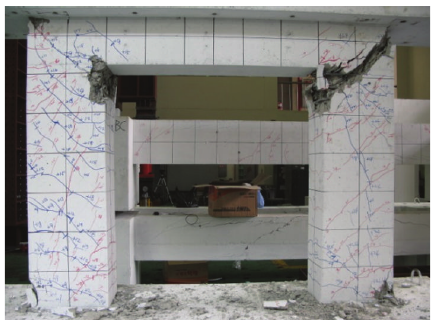
Figure 8: Test configuration.